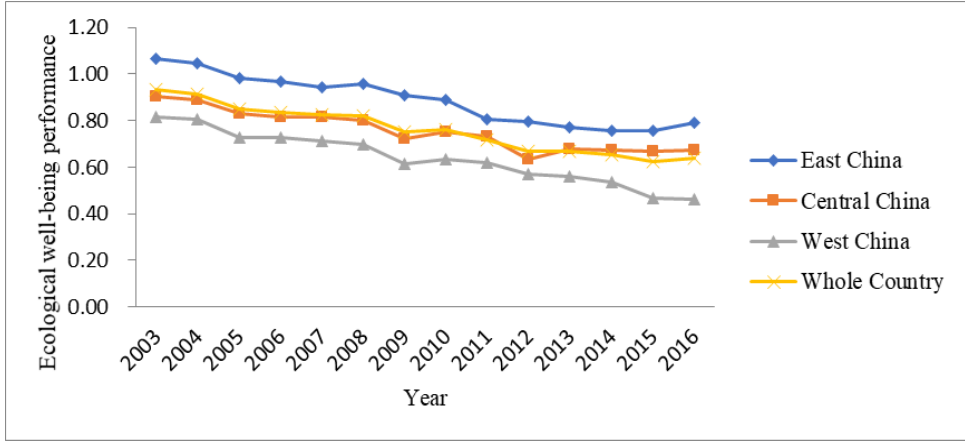
Figure 2. Evolutionary trend of ecological well-being performance in China from 2003–2016.